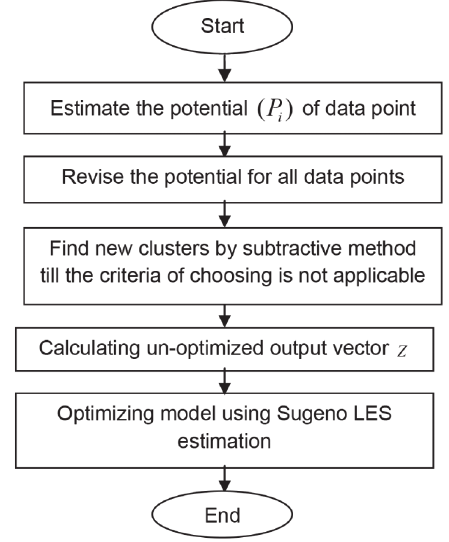
Fig. 2. Fuzzy clustering subtractive